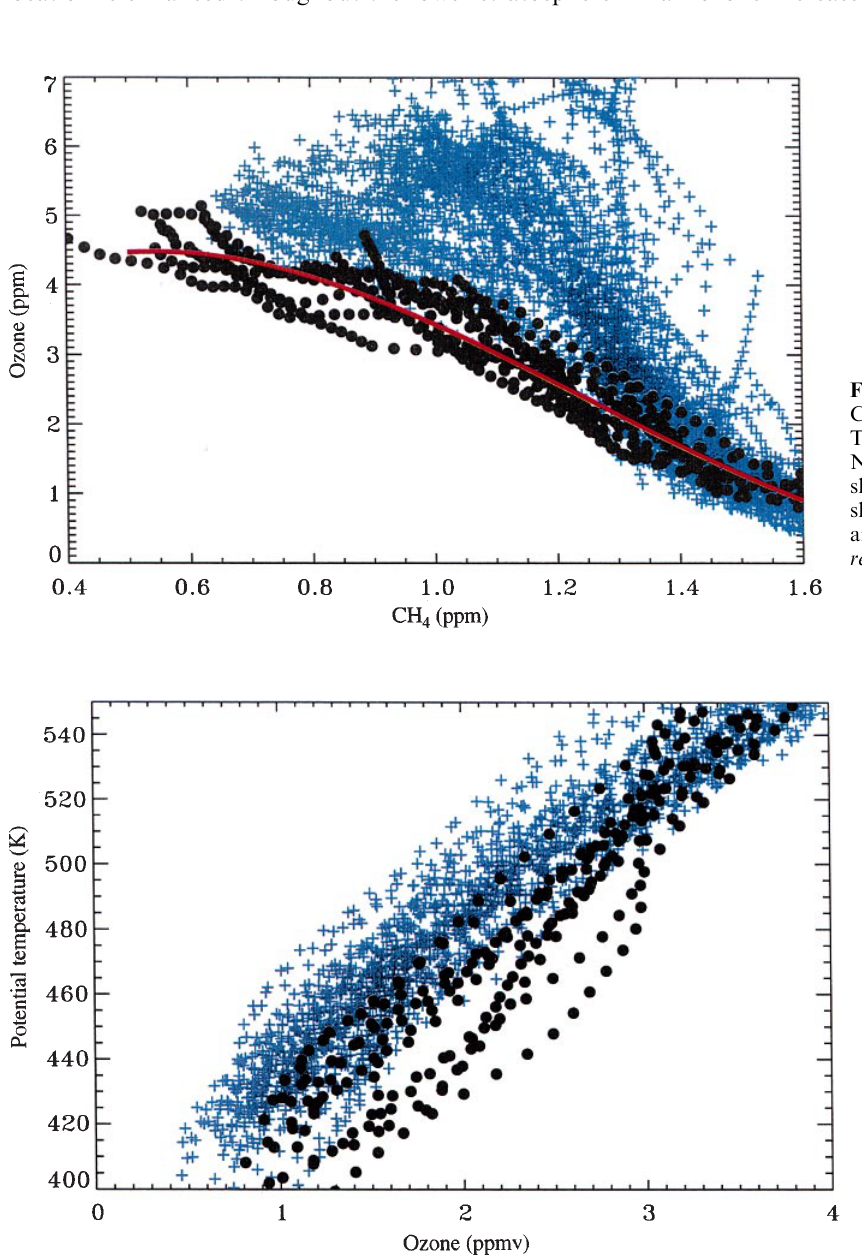
Fig. 11. As Fig. 10, but showing vertical profiles of O 3 mixing ratio (in ppmv) against potential temperature as the vertical coordinate. Measurements inside the vortex are shown as black circles , outside mea- surements are shown as blue plus